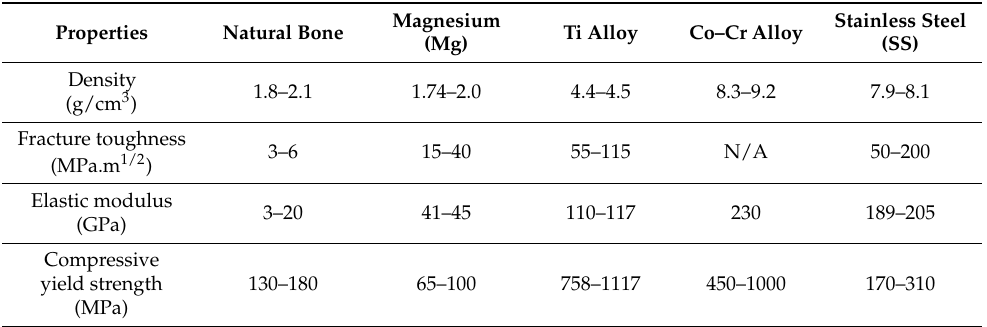
Table 1. Physical and mechanical properties of various implant materials in comparison to natural bone [57] .